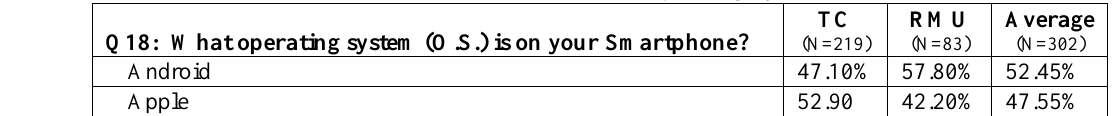
Table 1. RQ1: Preferred Operating System